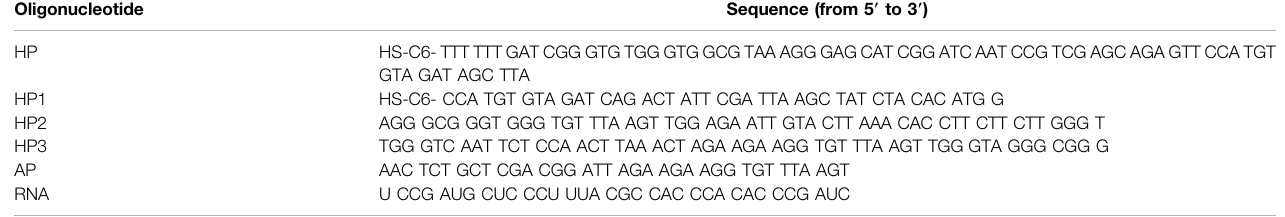
TABLE 1 | Oligonucleotides used in this work Oligonucleotide Sequence (from 5 9 to 3 9